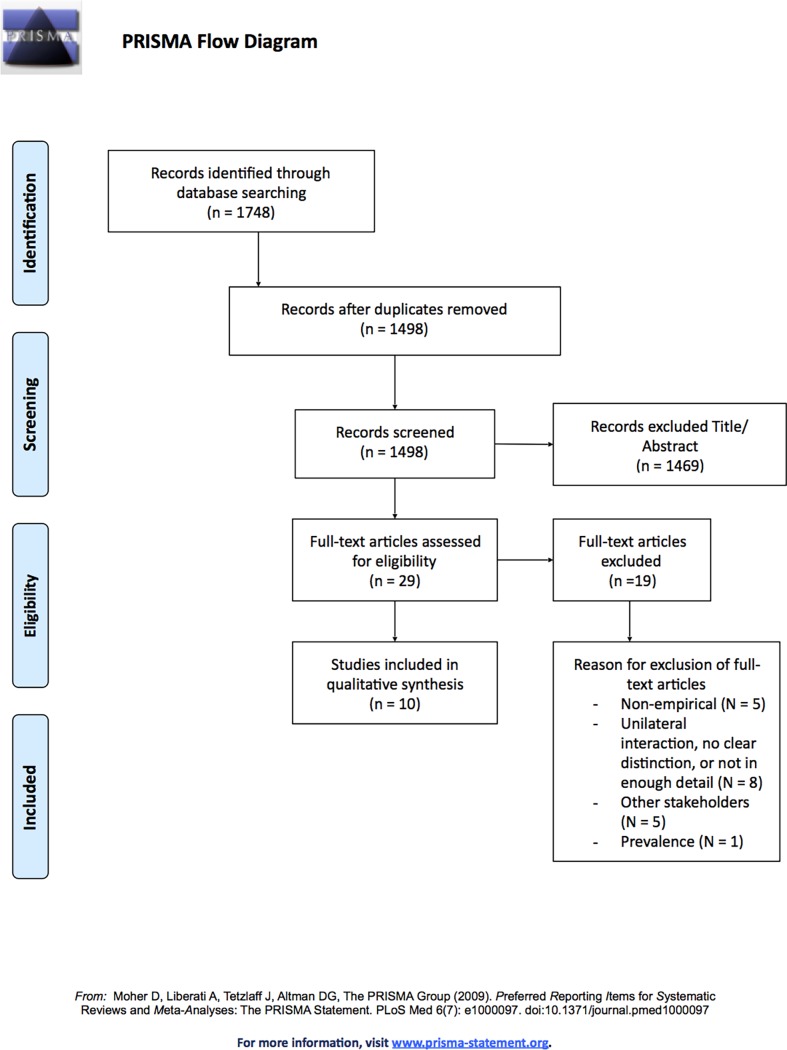
PRISMA flow diagram.